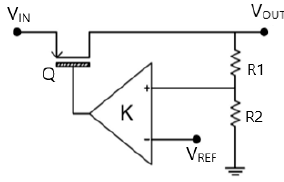
Figure 1. LDO voltage regulator principle [12].